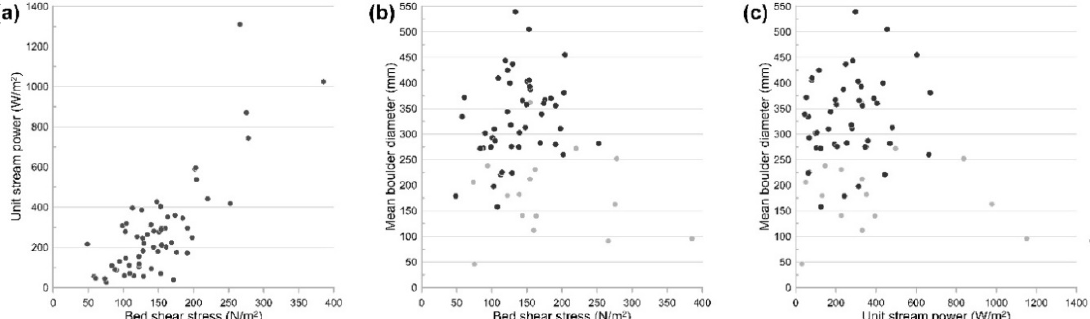
Figure 9. Plots between ( a ) the bed shear stress and unit stream power, ( b ) the bed shear stress and mean boulder diameter, and ( c ) the unit stream power and mean boulder diameter. The grey points in plots ( b ) and ( c ) indicate cross sections located in bedrock reaches or deep pools.